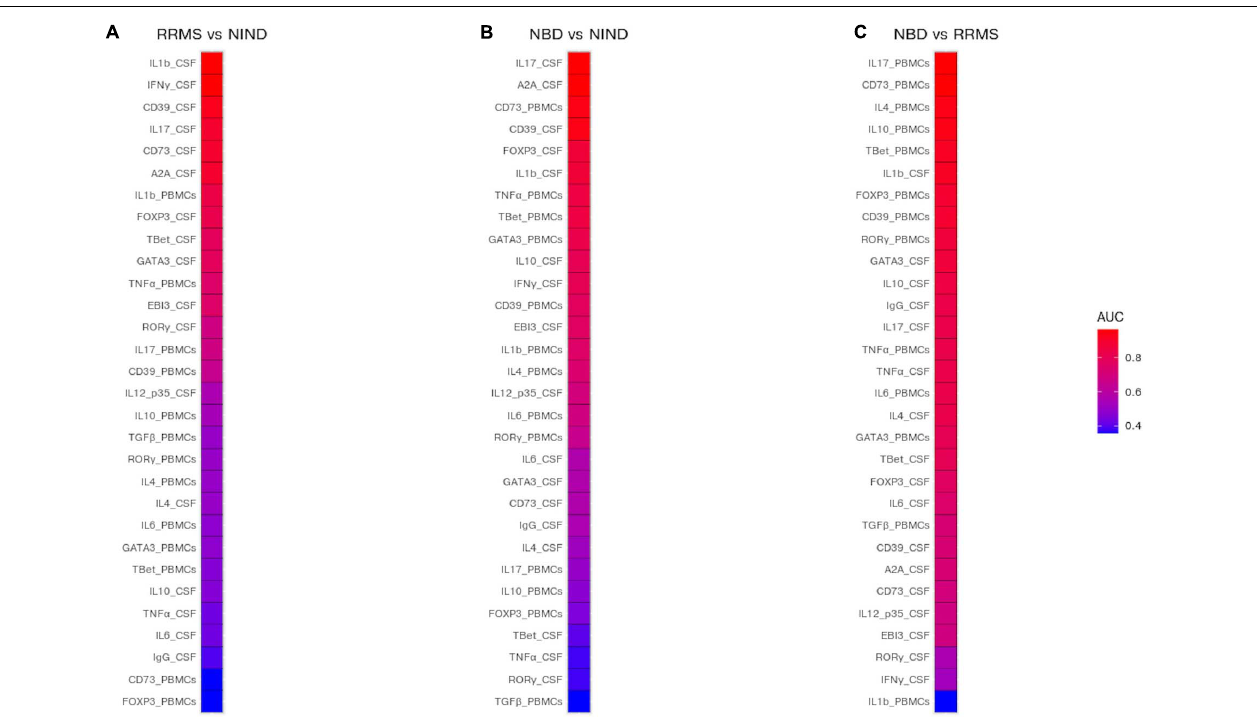
FIGURE 6 | Prediction of potential biomarkers to discriminate between NBD, RRMS, and NIND. The AUC was estimated for each CSF and blood variable and visualized in a heatmap. Color reflects the discriminatory strength of the variable between RRMS vs NIND (A) , NBD vs NIND (B) , and RRMS vs NBD (C) . An AUC of 1 means that the variable perfectly discriminates between patients, whereas an AUC of 0.5 means that the variable is